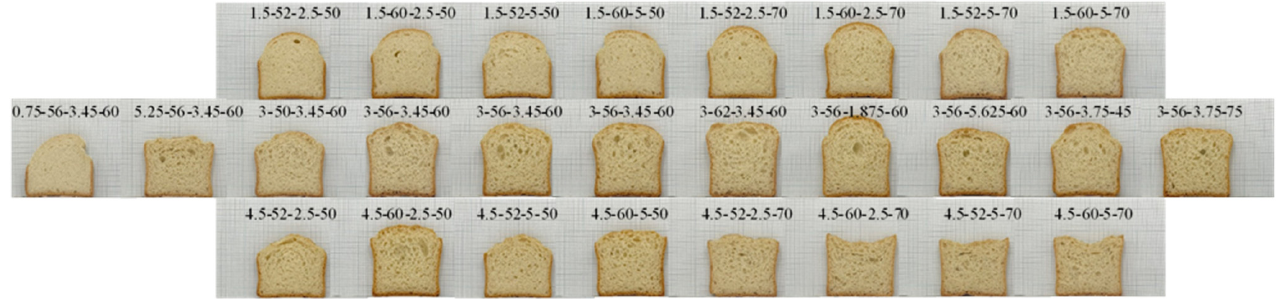
Figure 5. Cross ‐ section views of bread prepared with ‘O ‐ free flour’ at different formulation and Figure 5. Cross-section views of bread prepared with ‘O-free flour’ at different formulation and process- processing conditions (yeast ‐ water ‐ mixing time ‐ fermentation time) based on response surface ing conditions (yeast-water-mixing time-fermentation time) based on response surface